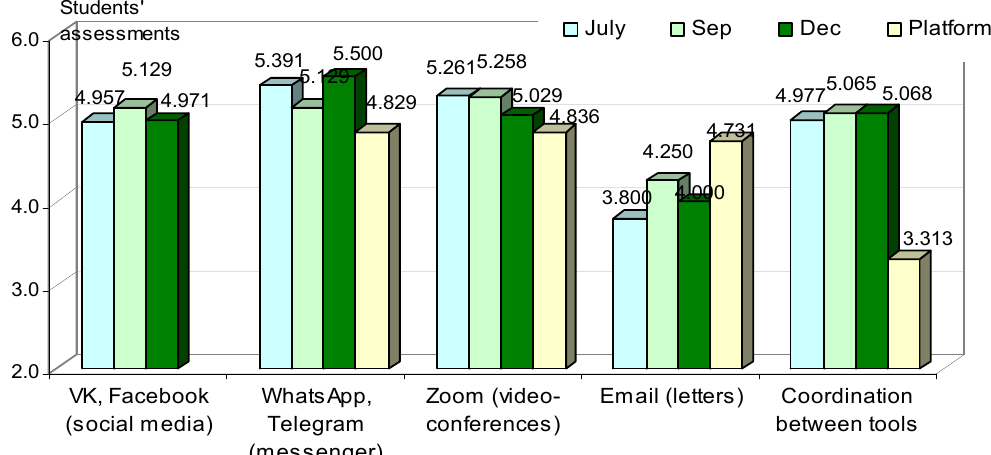
Figure 2. Summary of digital tools assessment results.